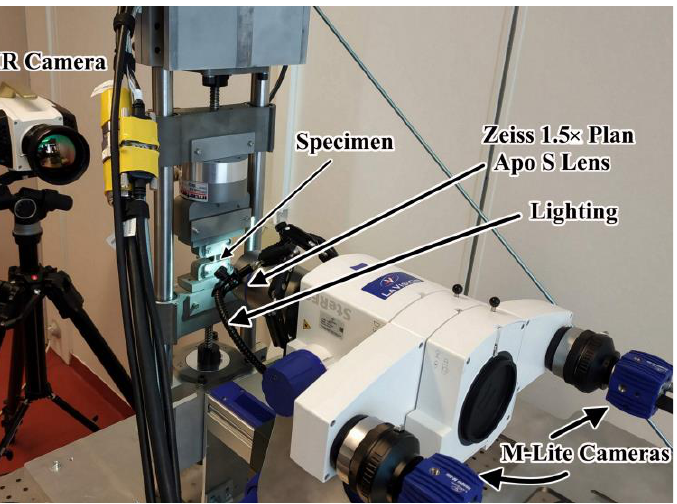
Figure 2. Experimental setup comprising the Psylotech µTS test system, stereo microscope, and infrared camera.